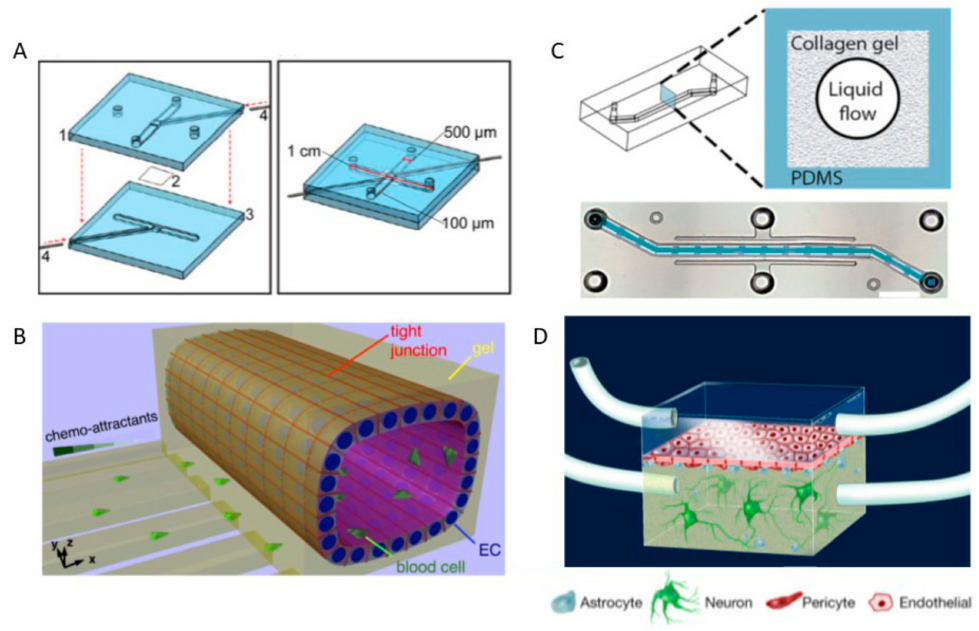
Figure 4. Schematic diagrams of BBB disruption models. ( A ) BBB chip. Figure adapted from [170]; ( B ) 3D in vitro BBB model [130]; ( C ) 3D microfluidic BBB chip [171]; ( D ) Neurovascular unit microfluidic device